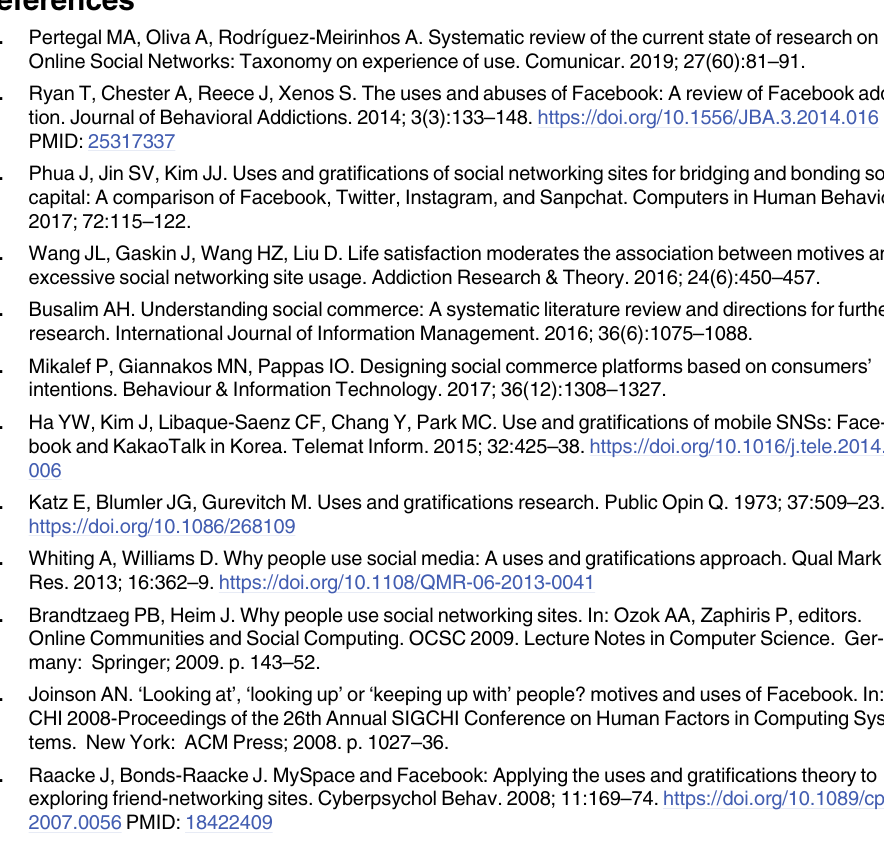
S1 Table. Items of the Scale of Motives for Using Social Networking Sites (SMU-SNS) for adolescents and youths–English